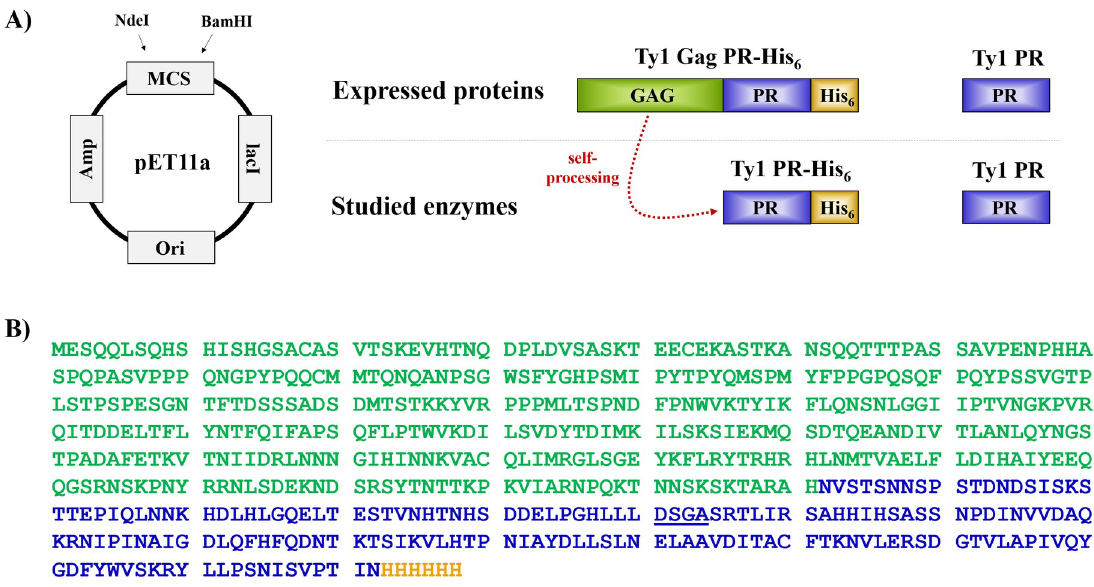
Fig 2. Studied forms of Ty1 protease. (A) Coding sequences were cloned into pET11a bacterial expression plasmid using NdeI and BamHI restriction endonucleases. The Ty1 Gag-PR-His 6 precursor polyprotein and the untagged protease have been expressed in bacterial cells. The Ty1 PR-His 6 is formed by the autoproteolysis (dashed red line) of Gag-PR-His 6 precursor protein. Abbreviations: Amp, ampicillin resistance gene; lacI, repressor protein gene; Ori, bacterial origin; MCS, multi cloning site. (B) Sequence of Ty1 Gag-PR-His 6 is shown. Color code: Gag, green; protease, blue; His 6 , orange. Active site motif is underlined.